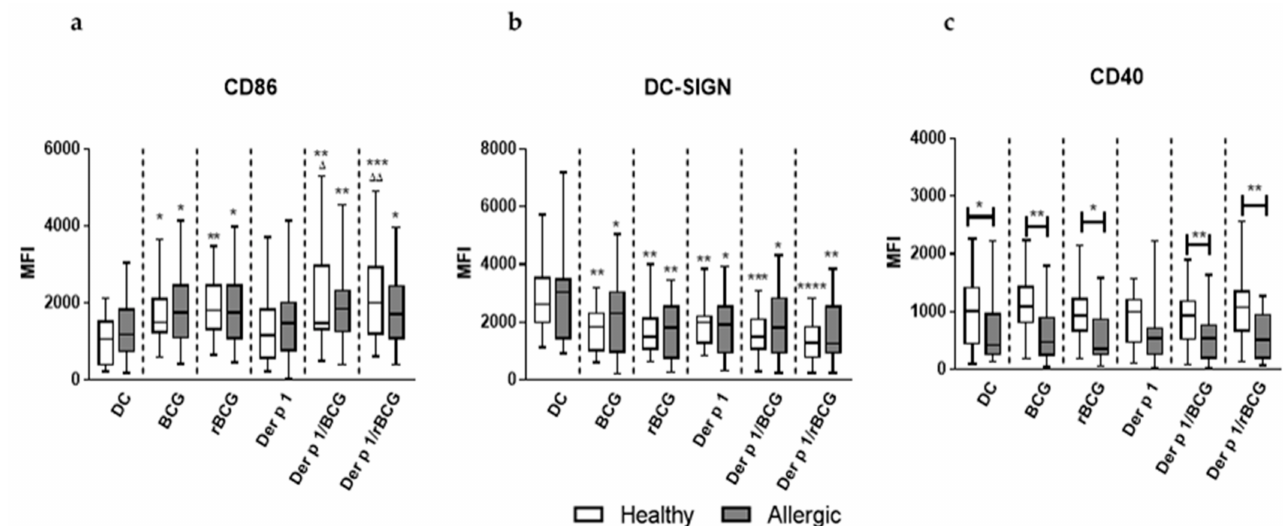
Figure 1. CD86 ( a ), DC-SIGN ( b ) and CD40 ( c ) surface expression on MD-DCs from healthy donors and allergic patients. Human MD-DCs were stimulated either with BCG (1:1), rBCG-hIL-18 (rBCG) (1:1), Der p 1 (1 µ g/mL), Derp1/BCG or Der p 1/rBCG-hIL-18 for 24 h or were left unstimulated (DC). Box plots represent the median MFI and interquartile range values for 22 allergic donors and 40 healthy donors. Fluorescence intensity was calculated by the MFI (once for each donor) of the receptor expression from which the MFI obtained with an isotype-matched antibody was subtracted. Statistical analyses were performed by using the Kruskal–Wallis non-parametric test. * p < 0.05; ** p < 0.01; *** p < 0.001; **** p < 0.0001; versus control (unstimulated DC), unless indicated by the horizontal bars; ∆ p < 0.05; ∆∆ p < 0.01 versus Der p